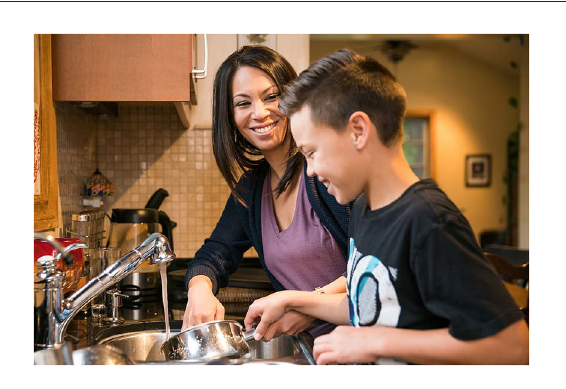
FIGURE1 Two humans interacting in a shared task with example common ground entities.